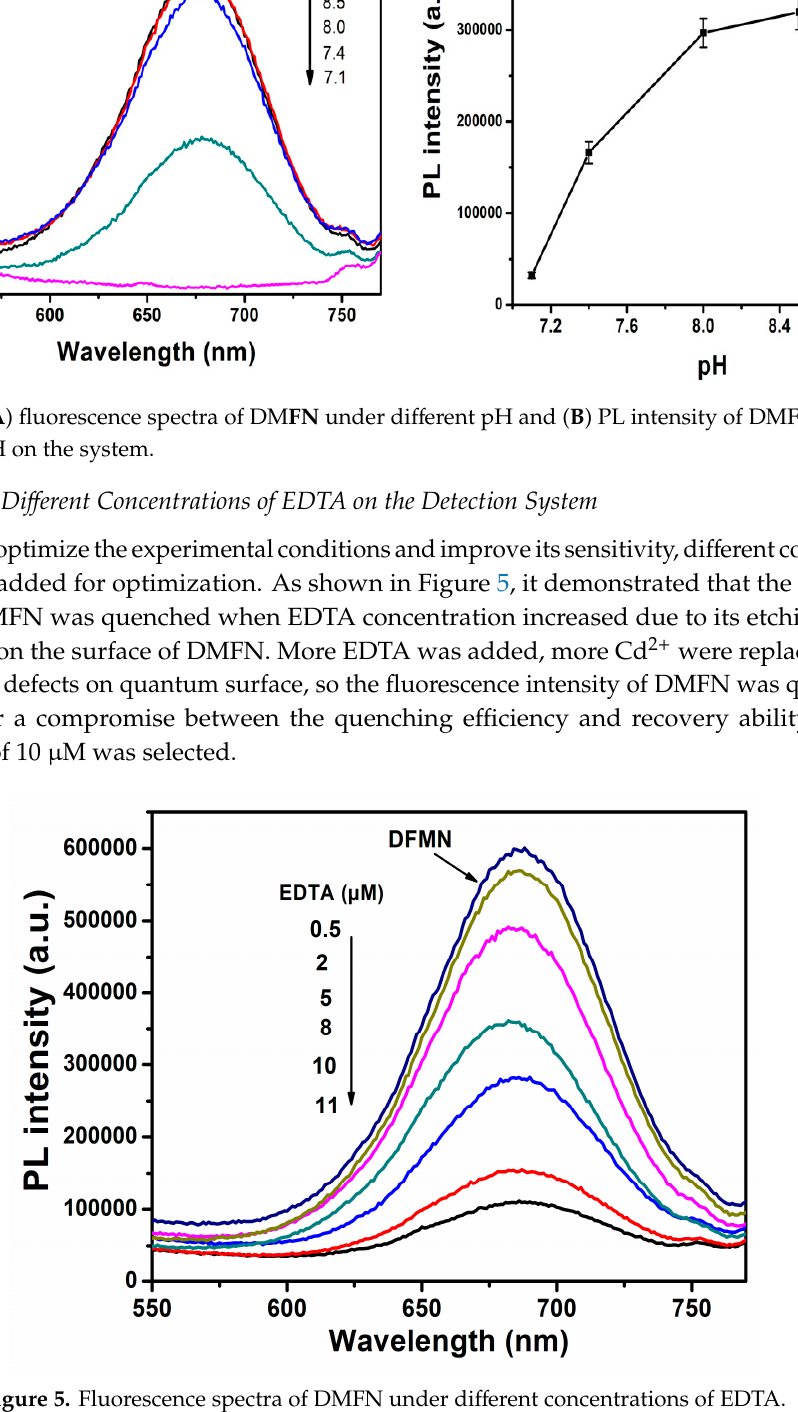
Figure 5. Fluorescence spectra of DMFN under different concentrations of EDTA.